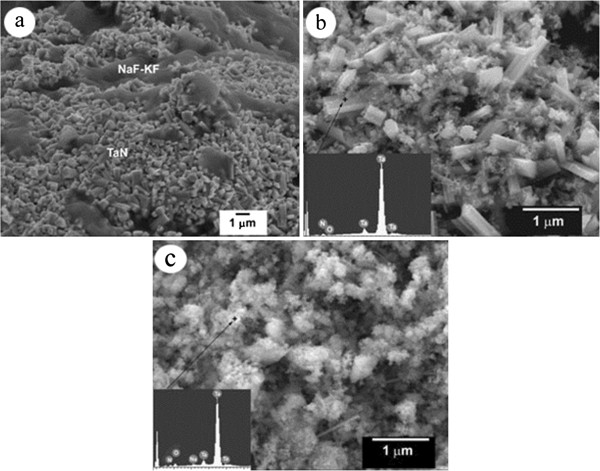
SEM micrographs of reaction product (a), and water-purified TaN samples with EDX analysis (b, c). (a) k = 0, (b) k = 0, and (c) k = 4.